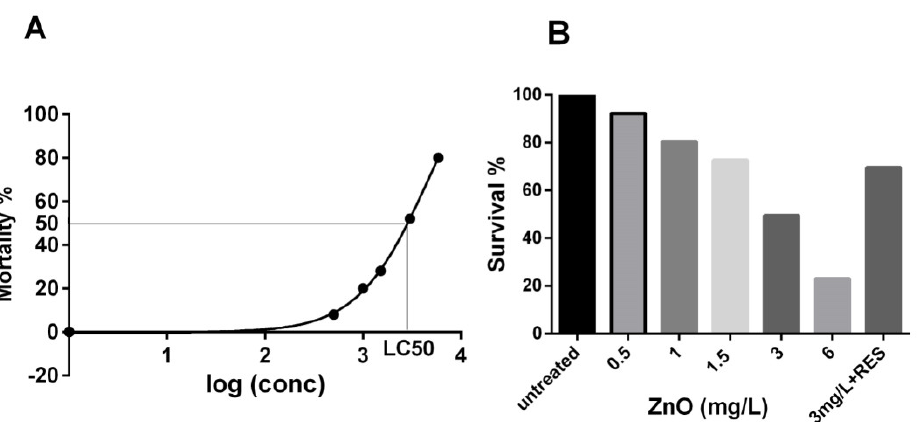
Figure 1. Resveratrol protects zebrafish embryos form ZnO NP-induced mortality. ( A ) log-dose vs. response curve for LC50 determination (see the Materials and Methods for more details). ( B ) The survival rate of the zebrafish embryos treated with different concentrations of ZnO NPs compared to the untreated control group and recovery assay following treatment with 5.0 μM resveratrol (3 mg/L + RES). RES, resveratrol.